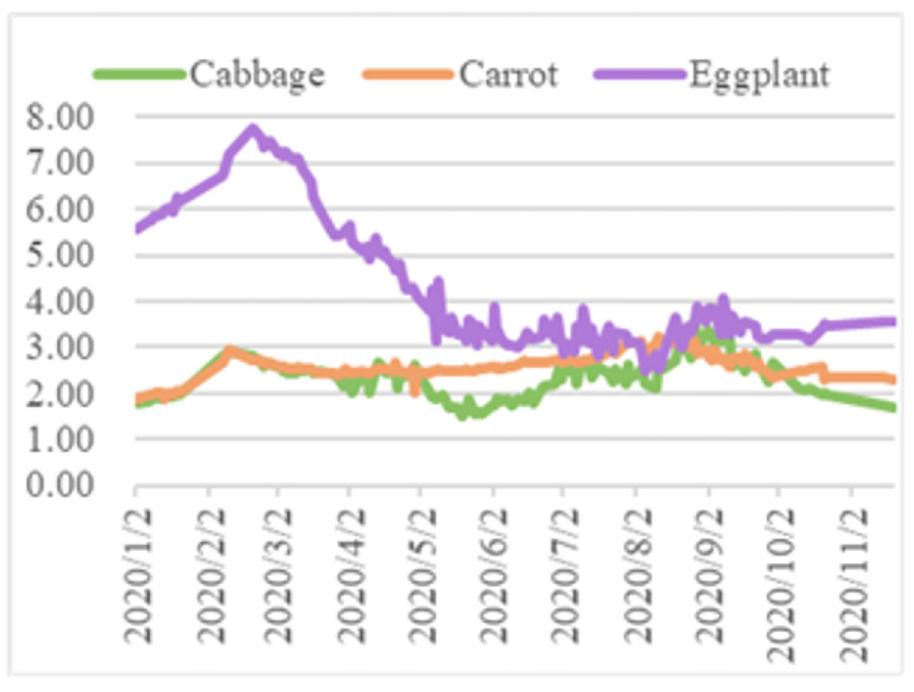
Fig 20. Average wholesale market price trends in